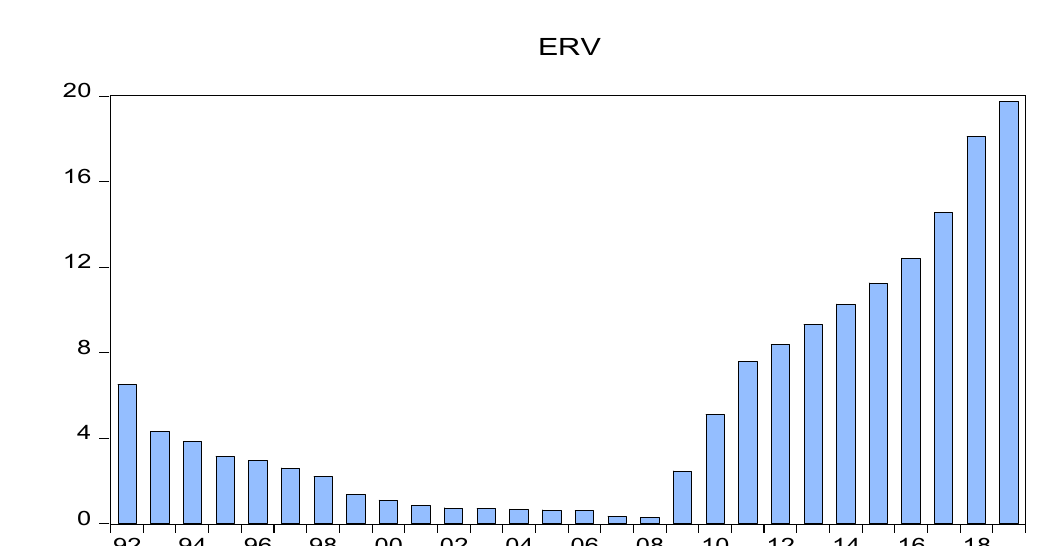
Figure 4. The movement of the exchange rate volatility (ERV) in Ethiopia. Source: Constructed by authors using E-view 10.